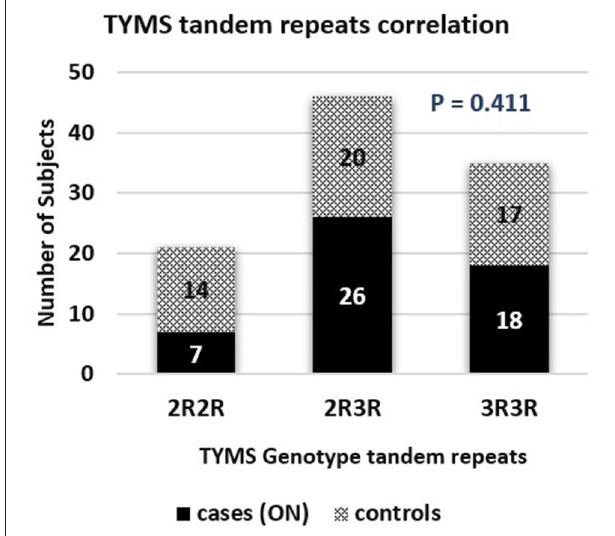
FIGURE 5 | TYMS tandem repeats correlation bar chart in osteonecrosis cases and